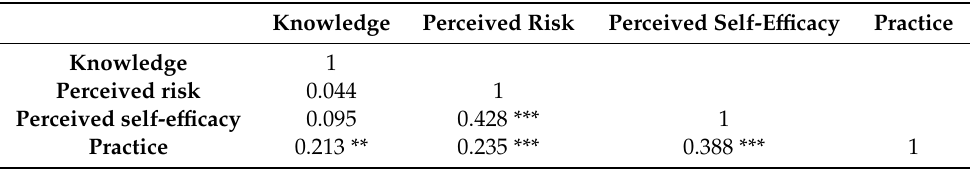
Table 6. Intercorrelation coe ffi cients between the scores of knowledge, perceived risk, perceived self-e ffi cacy, and practice.